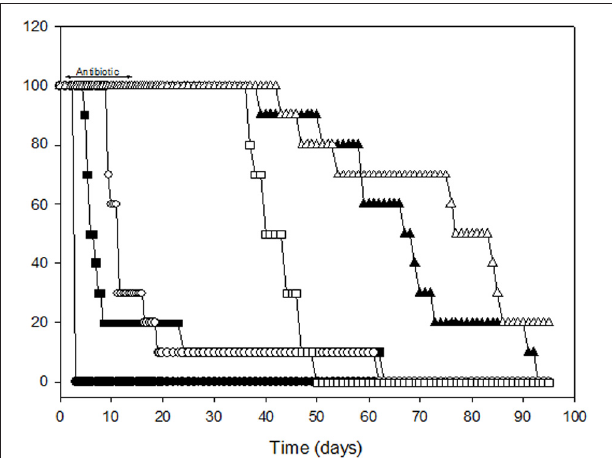
FIGURE 6 | Efficacy of antimicrobial chemotherapy with doxycycline or co-trimoxazole against infection caused by the deposition of B. pseudomallei K96243 within the lower or upper respiratory tract in 1 (closed symbols) or 12 µ m (open symbols) aerosol particles, respectively. Circles, untreated control mice; squares, doxycycline treated mice; triangles, co-trimoxazole treated